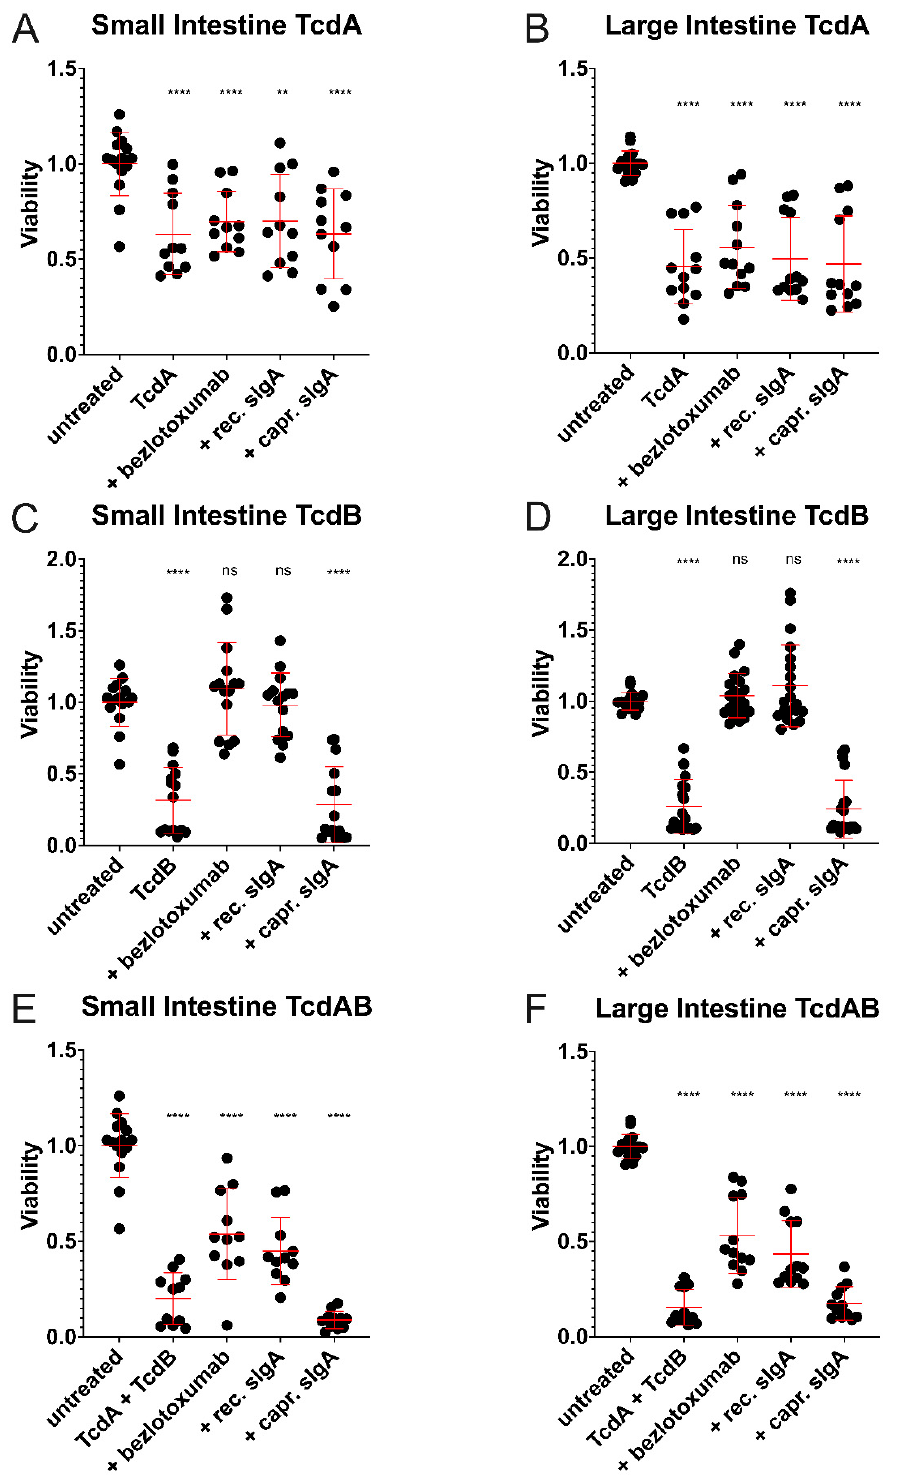
Figure 3. Respective potential of bezlotoxumab, recombinant sIgA and caprine sIgA to neutralise TcdA and/or TcdB, as revealed by sulforhodamine B cytotoxicity assays in ODM culture. Viability of ODMs from canine small and large intestinal organoids treated with TcdA ( A , B ), TcdB ( C , D ) or a combination of both toxins ( E , F ) following their incubation with bezlotoxumab, recombinant sIgA or caprine sIgA is shown. Student’s t -tests were performed with the viability of untreated control ODMs serving as a reference. Error bars indicate standard deviation from arithmetic means. ** p < 0.01, **** p < 0.0001, ns = non-significant.